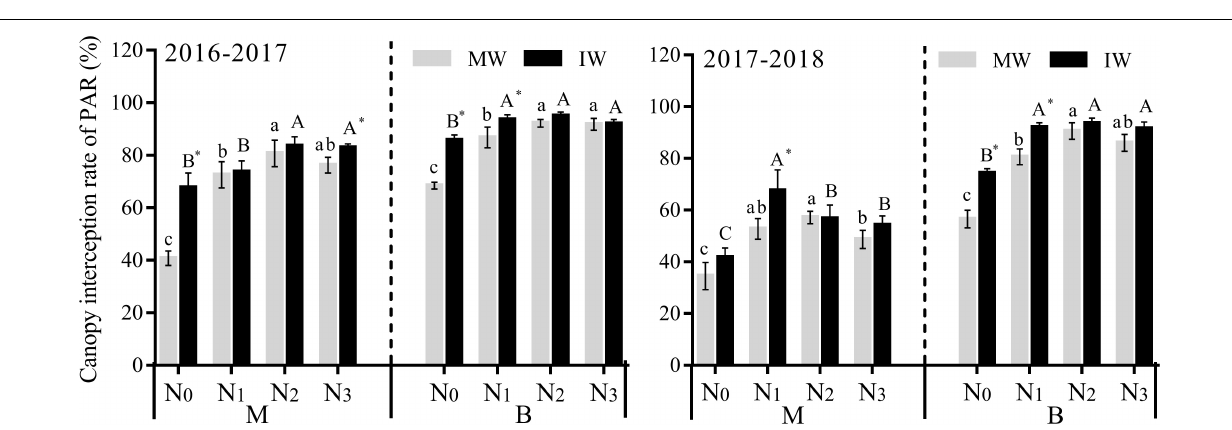
FIGURE 4 | Effects of applied nitrogen and intercropping on photosynthetically active radiation transmittance (IPAR) in the wheat canopy. MW, monocropped wheat; IW, intercropped wheat; M, middle of canopy; B, below of canopy. The different capital letters and small letters represent significant differences between different N levels in the same planting pattern at P < 0.05 levels. * Represents significant difference between monocropped and intercropped patterns at the same N level ( P <